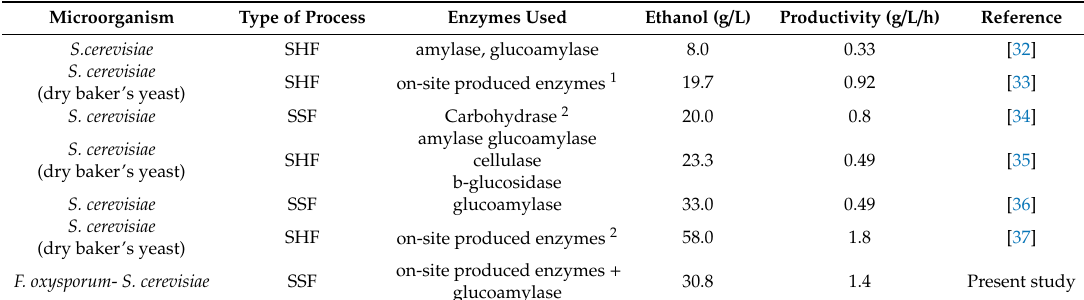
Table 2. Production of bioethanol from FW applying di ff erent